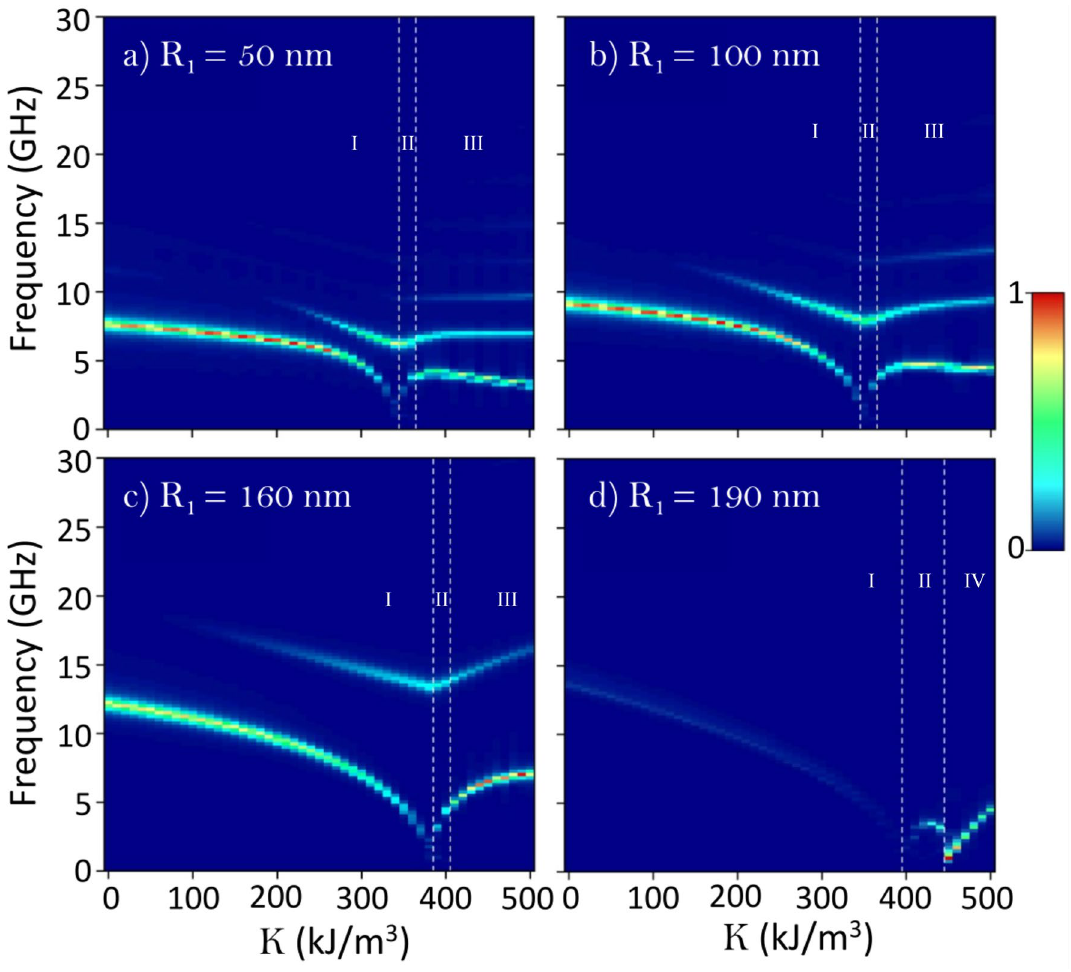
Figure 2. ( a ) Imaginary component of the dynamic susceptibility for a pulse in the x -direction as a function of the sample frequency and the RPMA strength K , for the magnetic nanoring with internal radii ( a ) R 1 = 50 , ( b ) 100, ( c ) 160 and ( d ) 190 nm. In each figure the lines (curves) with highest amplitude for the dynamical susceptibility correspond to the main modes of resonance. The depicted regions I,II, III and IV correspond to the regions where the vortex, knot, meron and uniform out-of-plane magnetic states, respectively, are stable in the